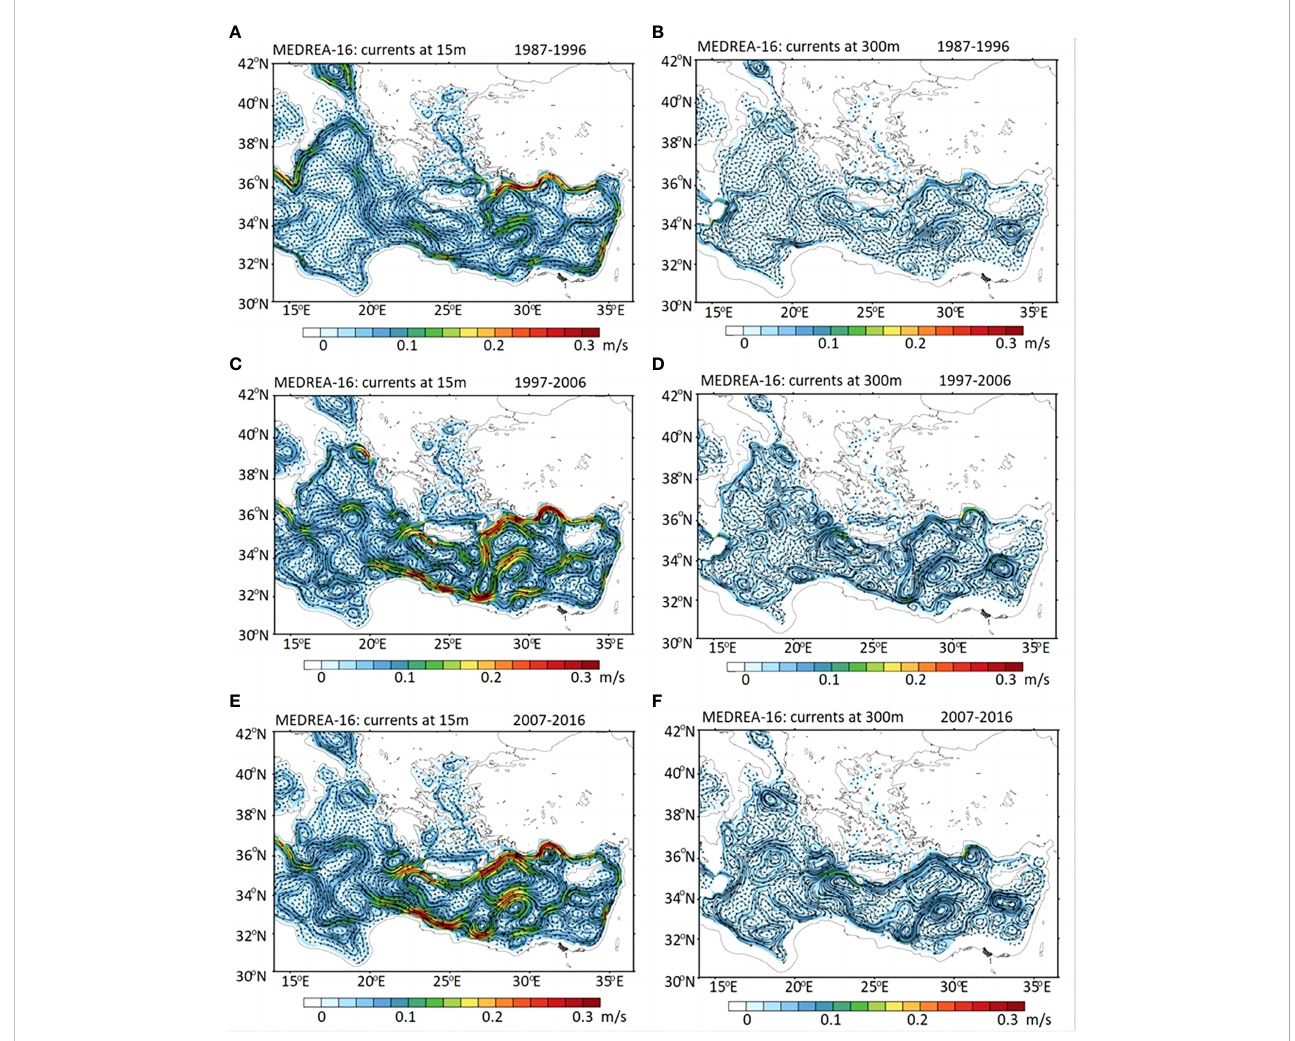
FIGURE 8 Surface decadal mean circulation in the Eastern Mediterranean from MEDREA16 reanalysis dataset (Simoncelli et al., 2014): (A) 1987-1996; (C) 1997- 2006; (E) 2007-2016. Decadal mean circulation at intermediate depth of 300m: (B) 1987-1996; (D) 1997-2006; (F)